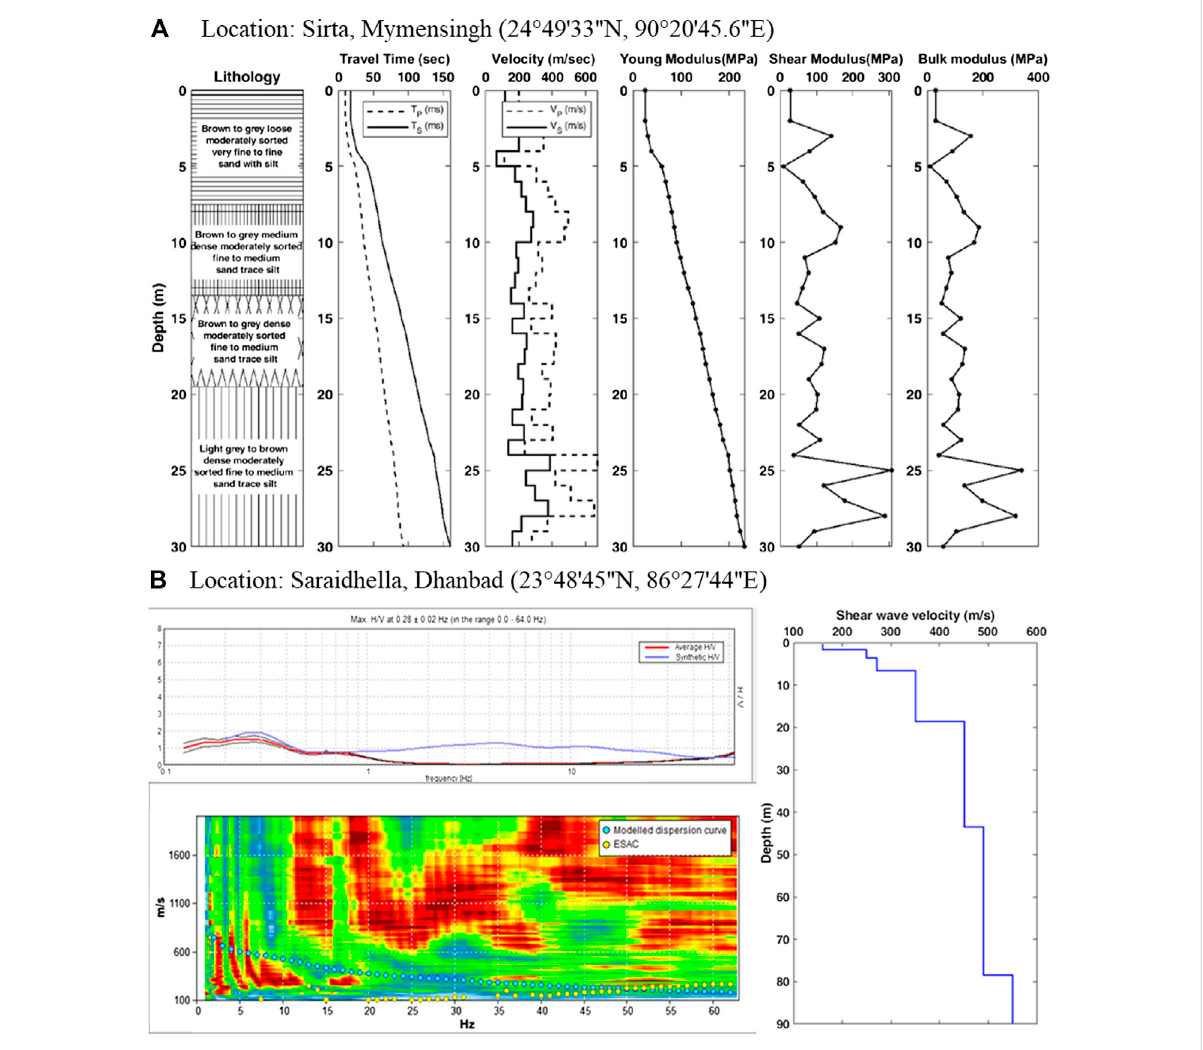
FIGURE 7 (A) Downhole dataset with travel time, depth-wise P- and S-wave velocity, Young ’ s, shear, and bulk moduli in Sirta, Mymensingh and (B) representativejointinversionofH/V curvesderived fromtheambientnoise surveyandtheMASW-deriveddispersioncurve,wherein1-D shearwave velocity section has been generated in Saraidhella,